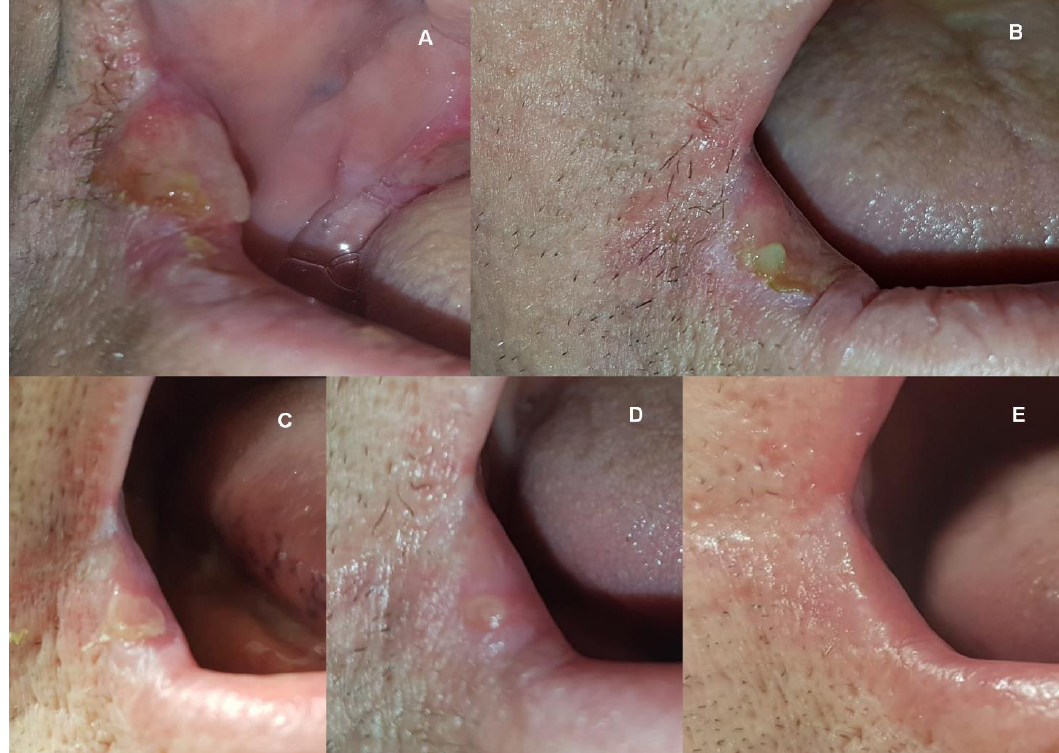
Figure 3. Views of the ulcer in the right labial commissure just before the 1st PBM treatment ( A ), on the 4th day before the 2nd PBM ( B ), on the 7th day before the 3rd PBM ( C ), on the 14th day before the 5th PBM ( D ), and on the 21st day before the 7th and last PBM treatment ( E ).